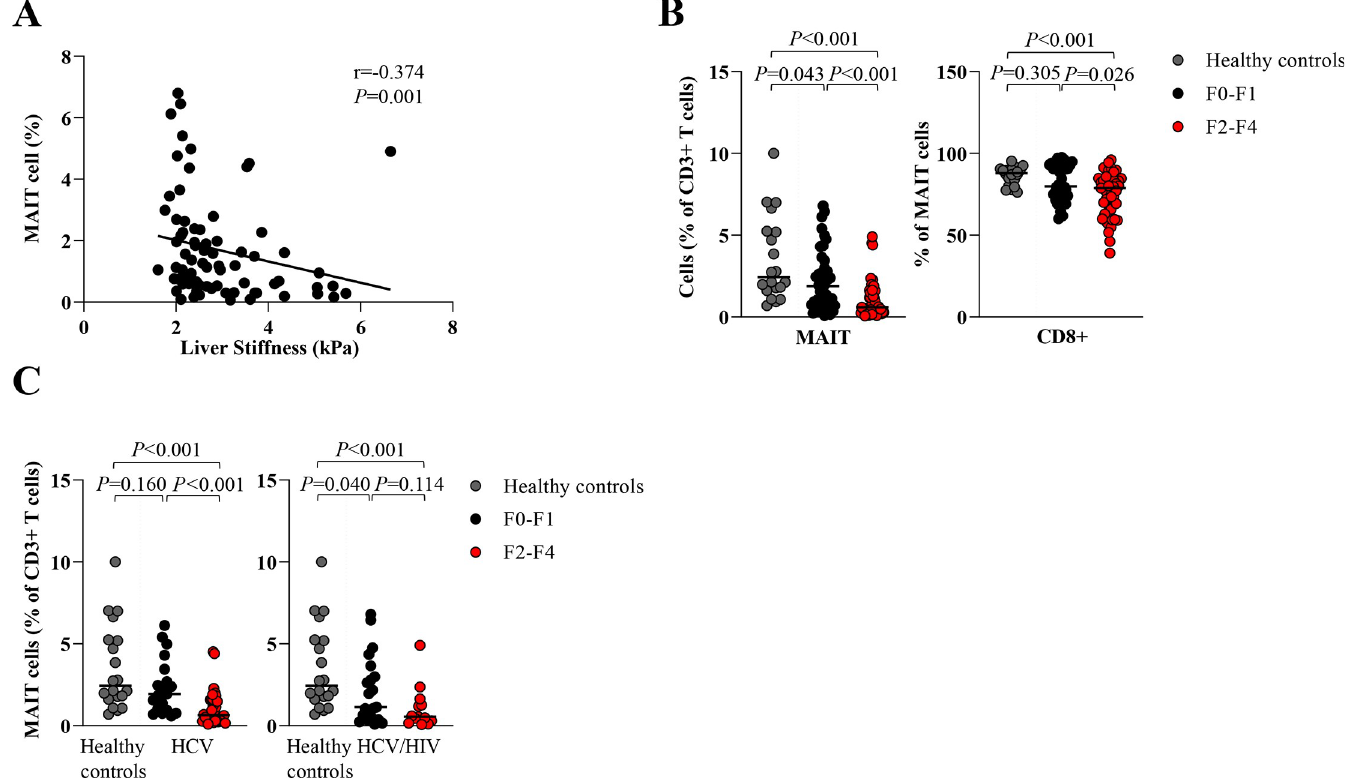
Fig 2. Circulating MAIT and CD8+ MAIT cells according to liver fibrosis stages. (A) Correlation between frequency of MAIT cells and liver stiffness. (B) Percentage of total MAIT cells and CD8+ MAIT cells in patients with no to mild fibrosis (F0-F1) and significant fibrosis to cirrhosis (F2-F4) compared to healthy controls. (C) Percentage of total MAIT cells in HCV-monoinfected patients (HCV) and HCV/HIV-coinfected patients (HCV/HIV) with F0-F1 and F2-F4 compared to healthy controls. Data presented as median and interquartile range (IQR). Correlations were assessed by Spearman’s rank test (A). Statistical analysis was performed using Mann-Whitney test